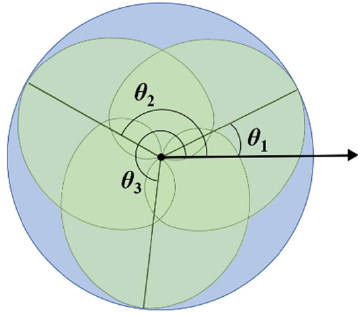
Figure 5. Schematic diagram of the “shamrock” covering model built in polar coordinate system.